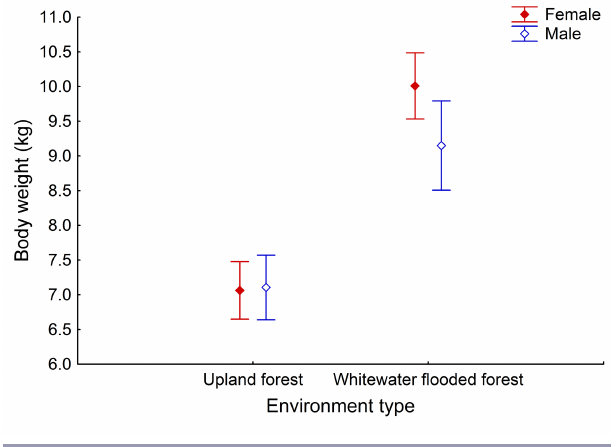
Fig. 2 . Influence of the sex and the environment on the weight of yellow-footed tortoises ( Chelonoidis denticulata ) hunted in the Brazilian Amazon. The bars represent 95% confidence intervals.